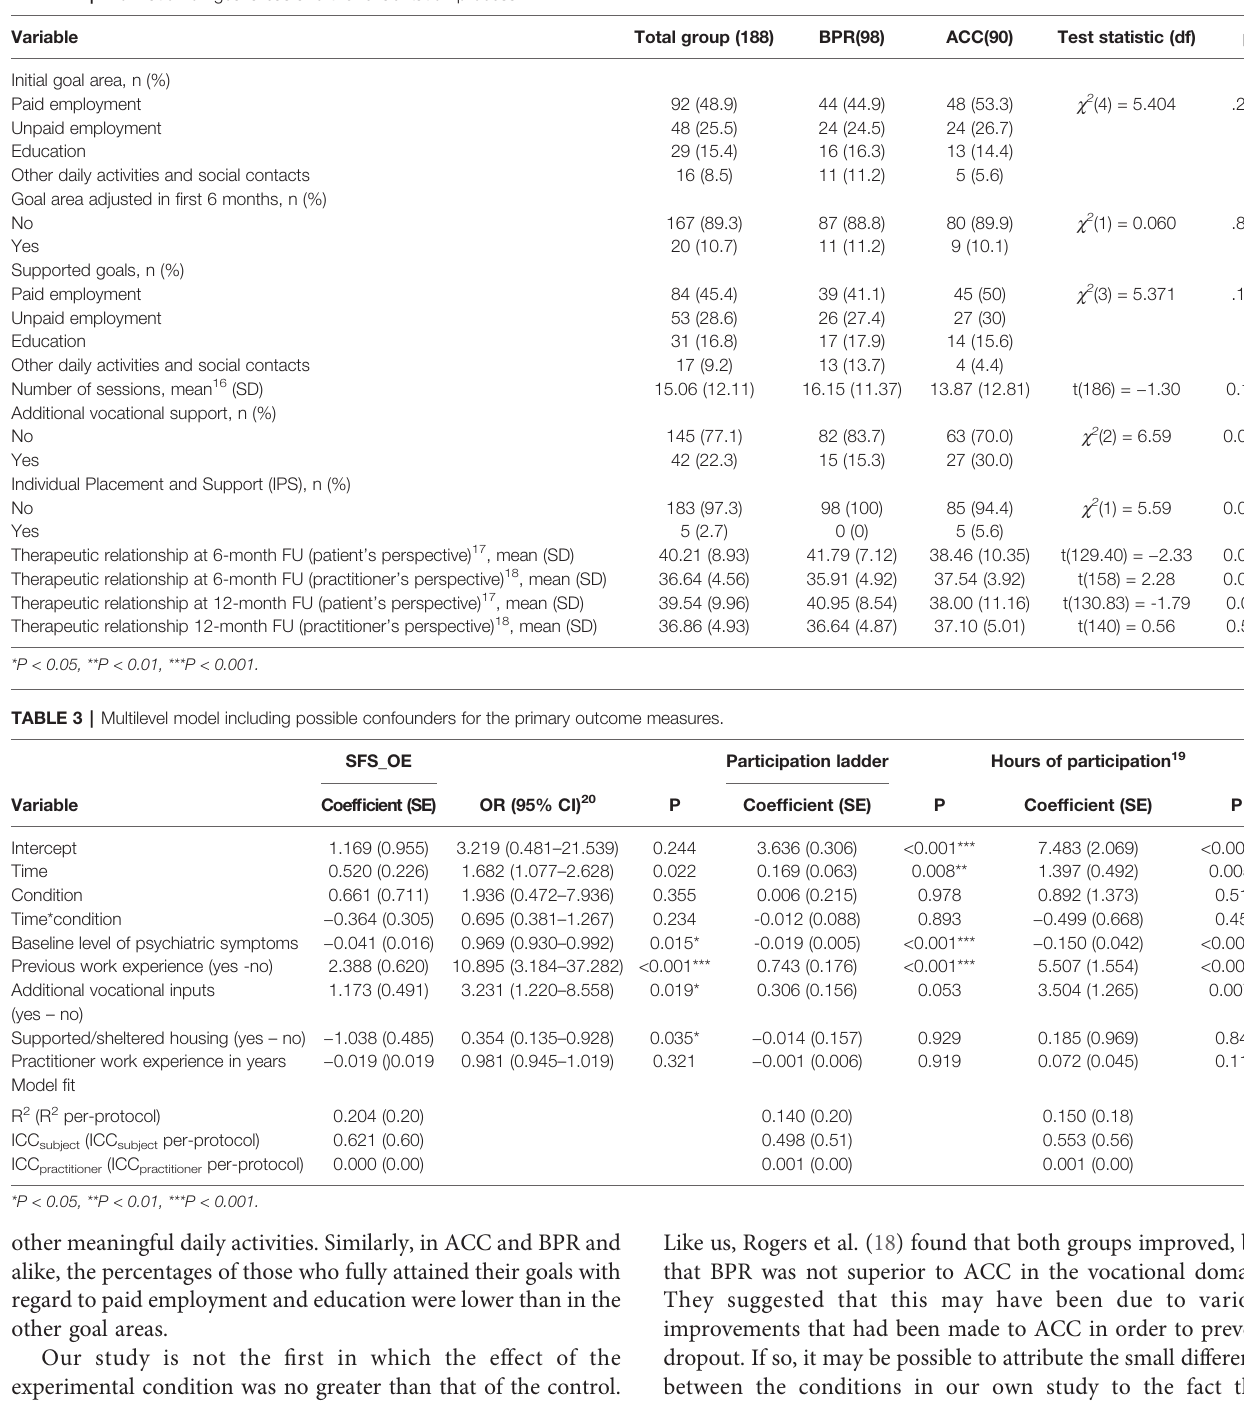
TABLE 2 | Information on goal areas and the rehabilitation process.